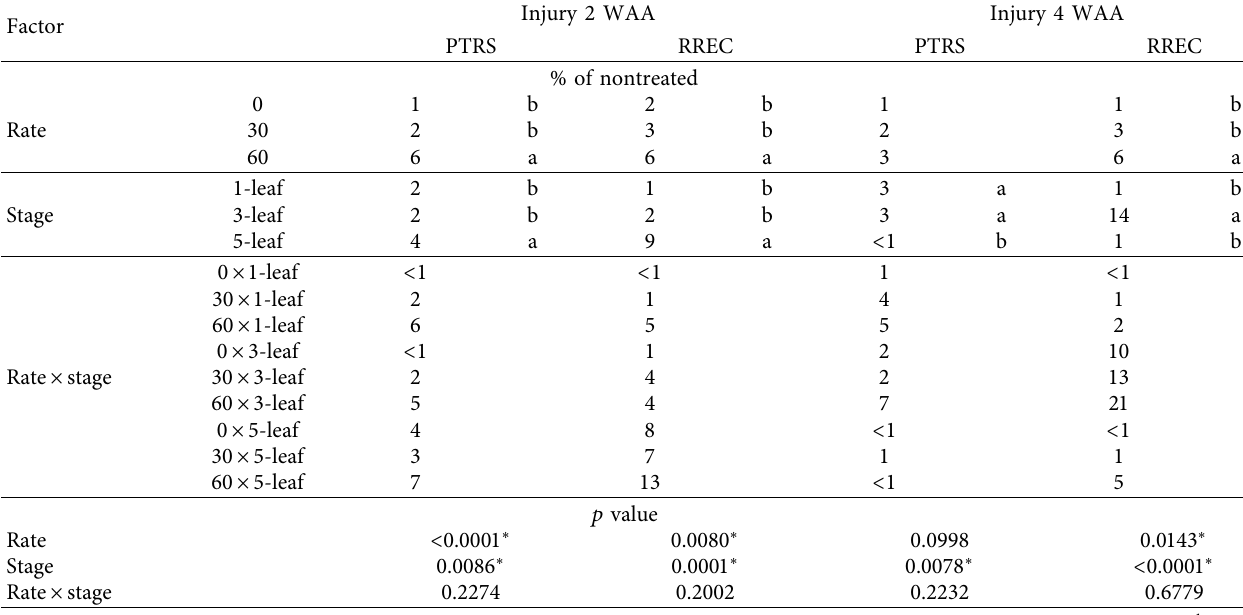
Table 4: Rice injury for CL272 as influenced by florpyrauxifen-benzyl rate applied with imazethapyr at various rice growth stages a,b,c .